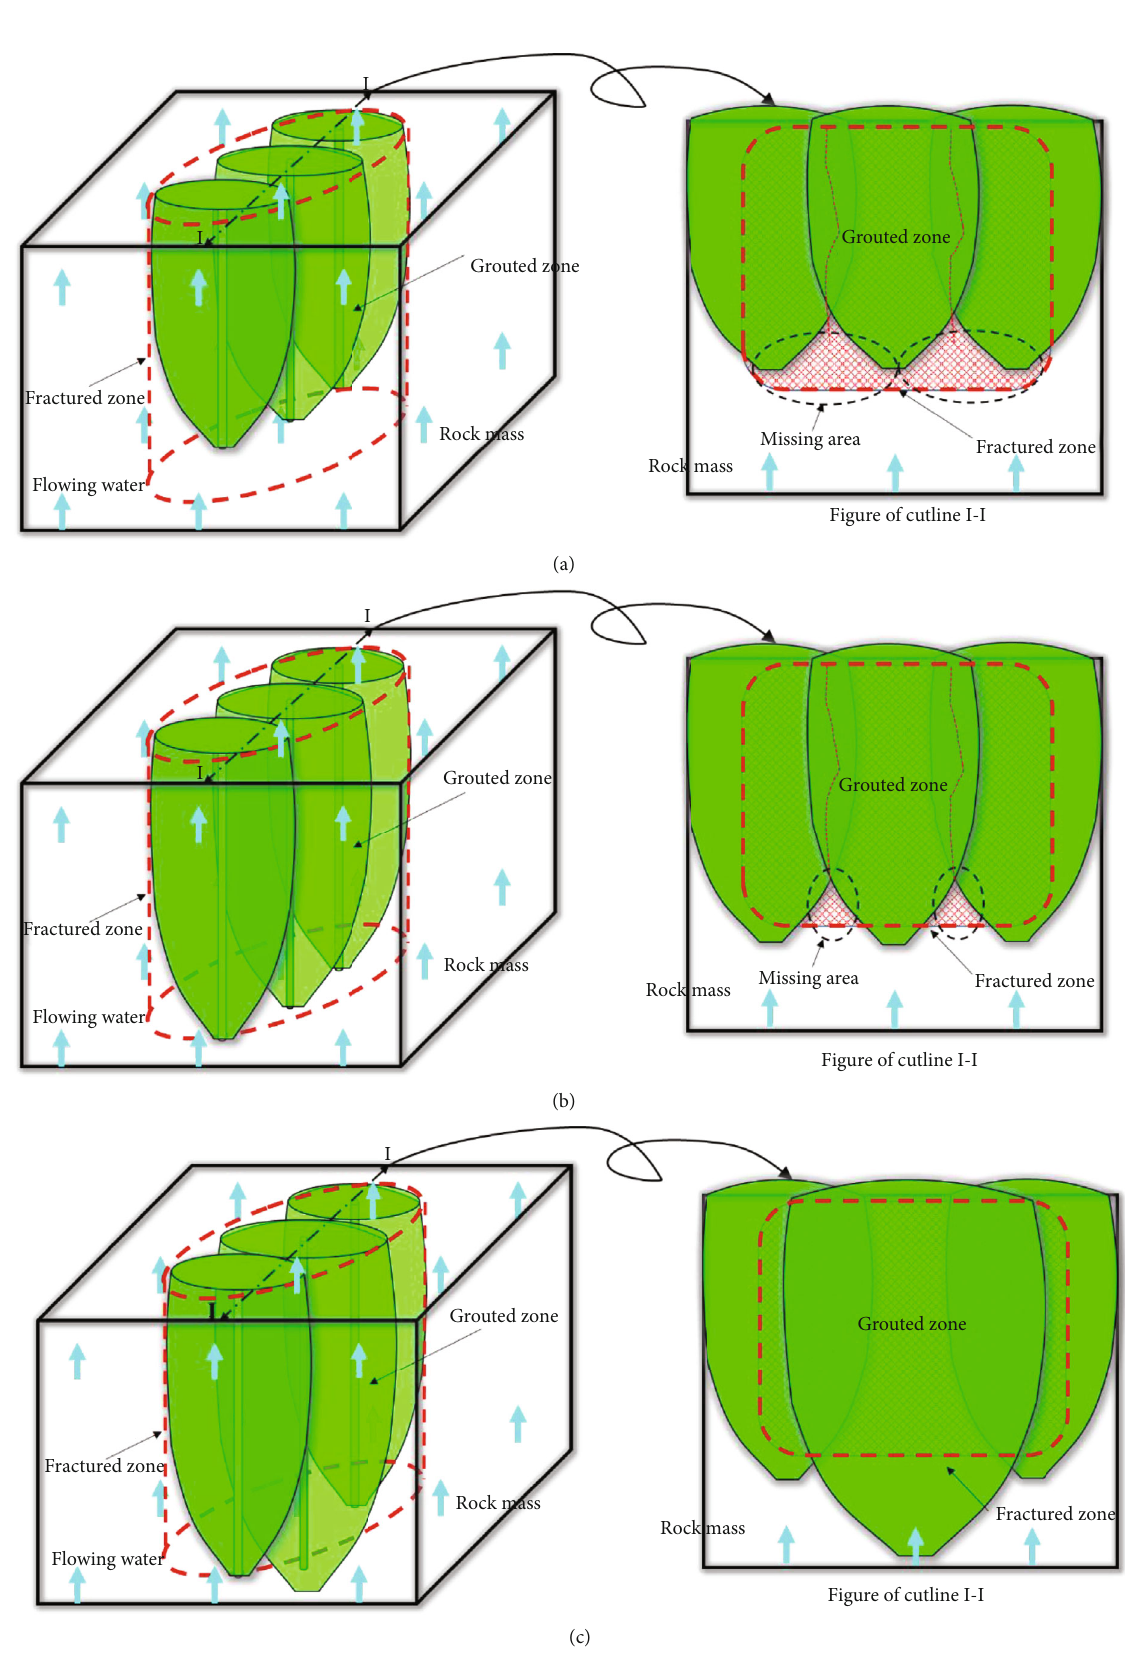
Figure 9: Slurry di ff usion under di ff erent designs of grouting holes. (a) Slurry di ff usion of drilling hole at side of noninlet water. (b) Slurry di ff usion of drilling hole at side of inlet water with same level. (c) Slurry di ff usion of drilling hole at side of inlet water with di ff erent